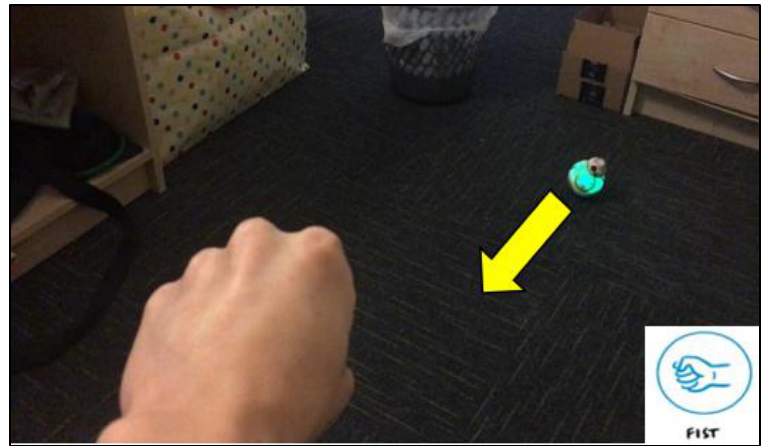
Figure 6. Fist gesture activates Backward robot